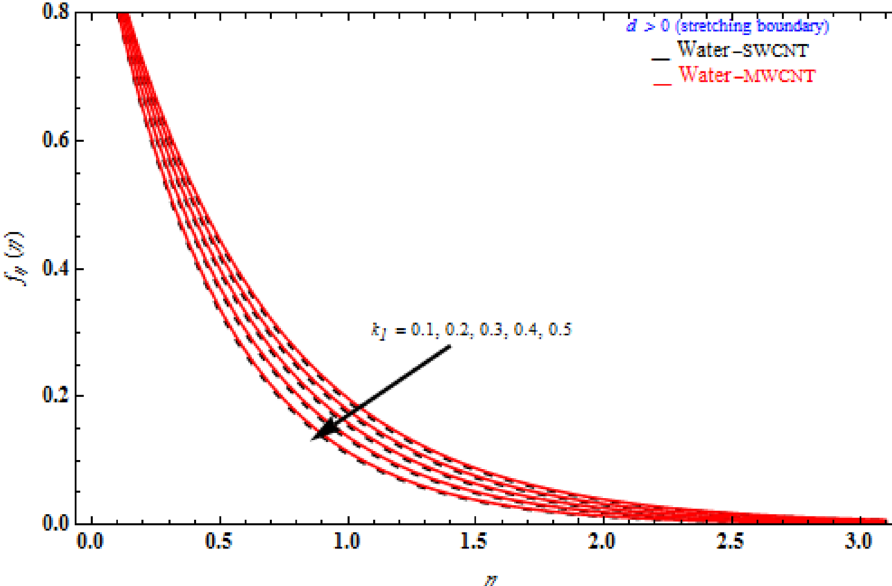
Figure 8. Impact of k 1 on axial velocity with Da -1 = 1, M = 1, τ = 90° for stretching case.